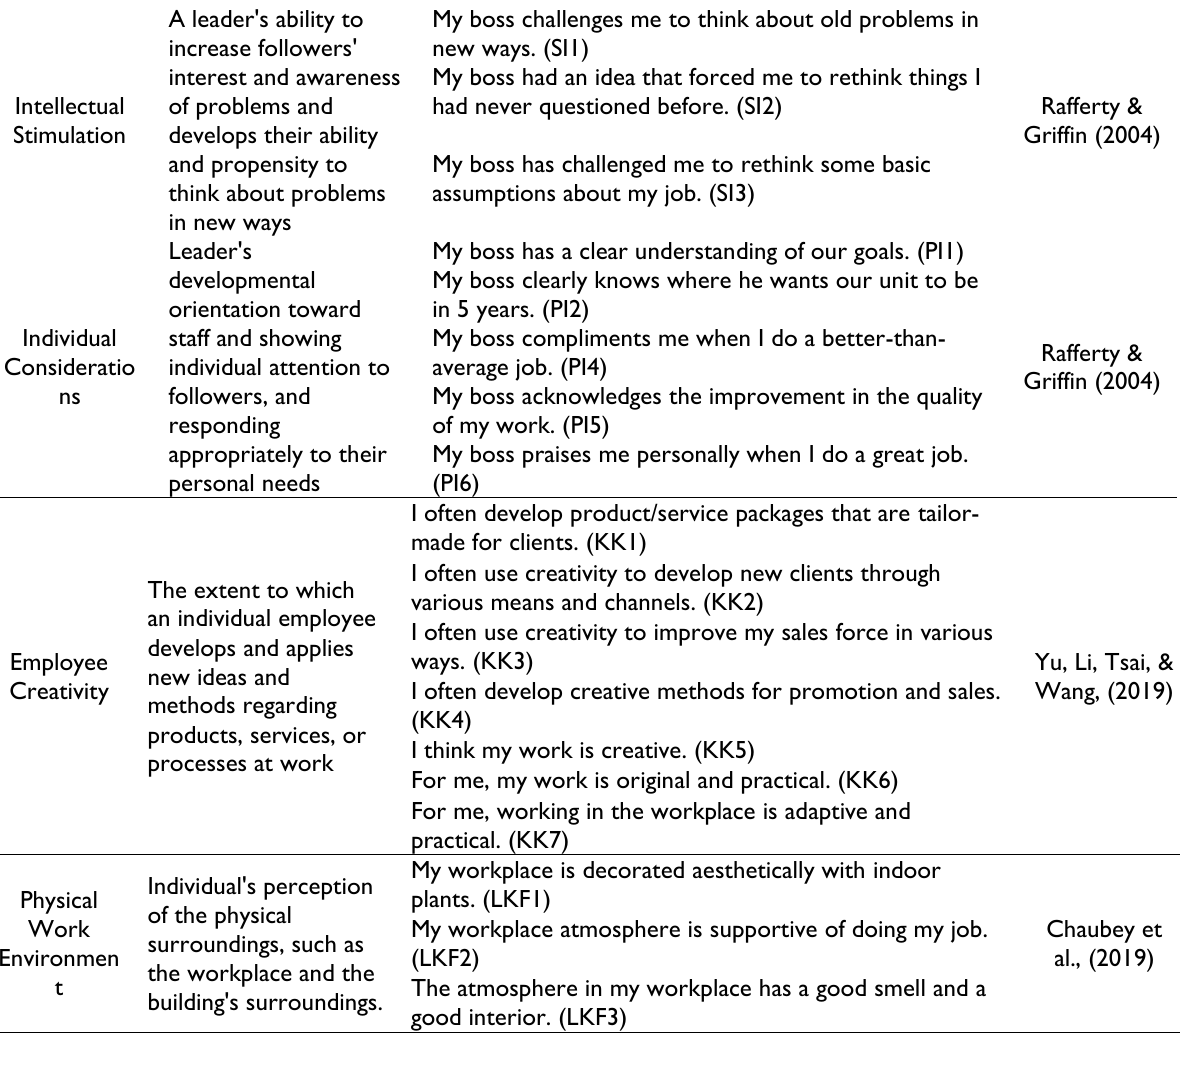
Table 2. Convergent Validity and Reliability